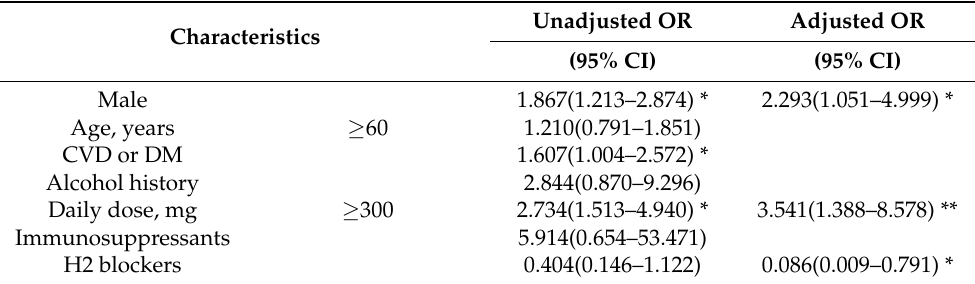
Table 3. Univariate and multivariate analyses to identify predictors for hepatotoxicity related to nilotinib